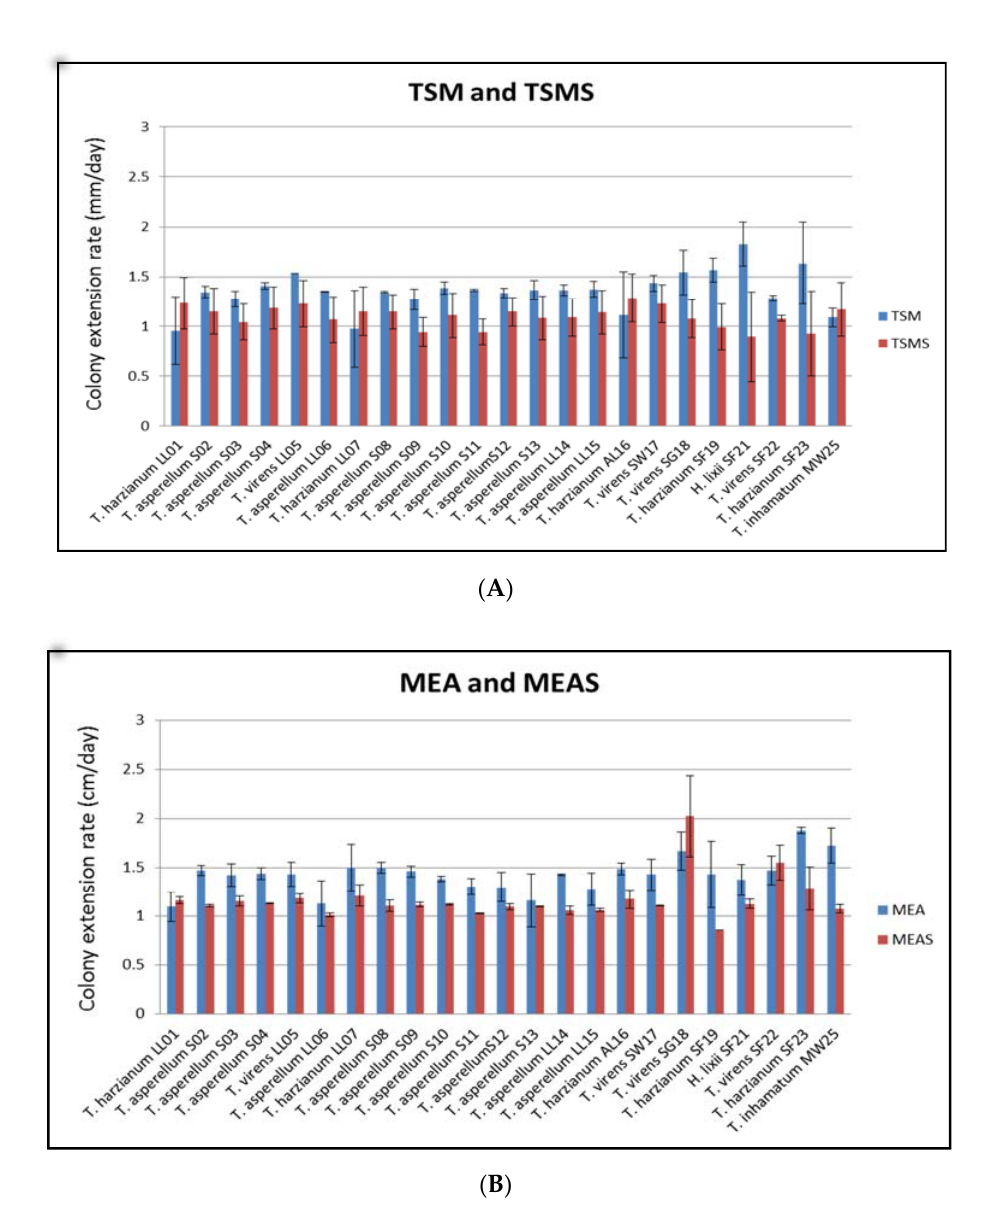
Figure 3. Colony extension rates of Trichoderma strains grown on ( A ) TSM agar and TSM agar with marine salts (TSMS) and ( B ) MEA and MEA with marine salts (MEAS). The substrate codes were as follows: leaf litter (LL), soil (S), seaweed (SW), seagrass (SG), sea foam (SF), marine water (MW), and aerial leaf litter (AL). Table 2. Tolerance assay of Trichoderma strains at different concentrations of